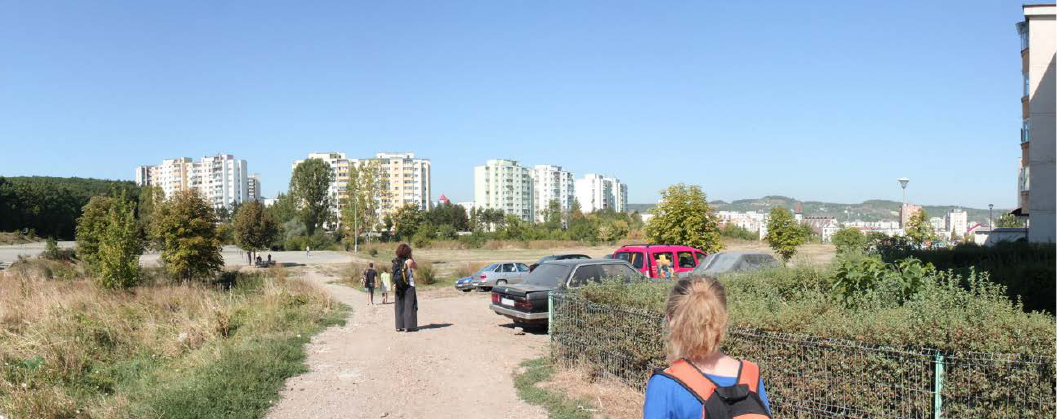
Figure 7: Green areas: public or private? Open or